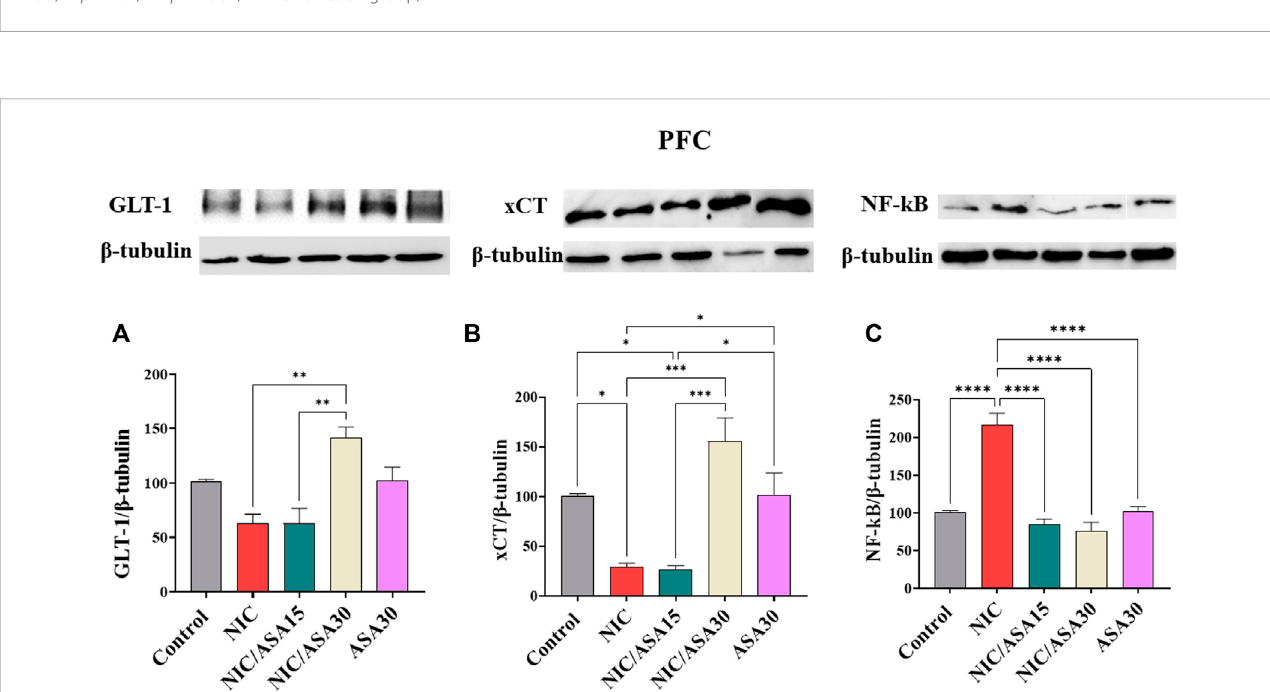
FIGURE 6 GlutamatetransporterslevelinPFCbrainregionsaftertreatments(dataexpressedasmean±SEM). (A) GLT-1; (B) xCT; (C) NF κ B(* p < .05,** p < .01,*** p < .001; n = 5 for each